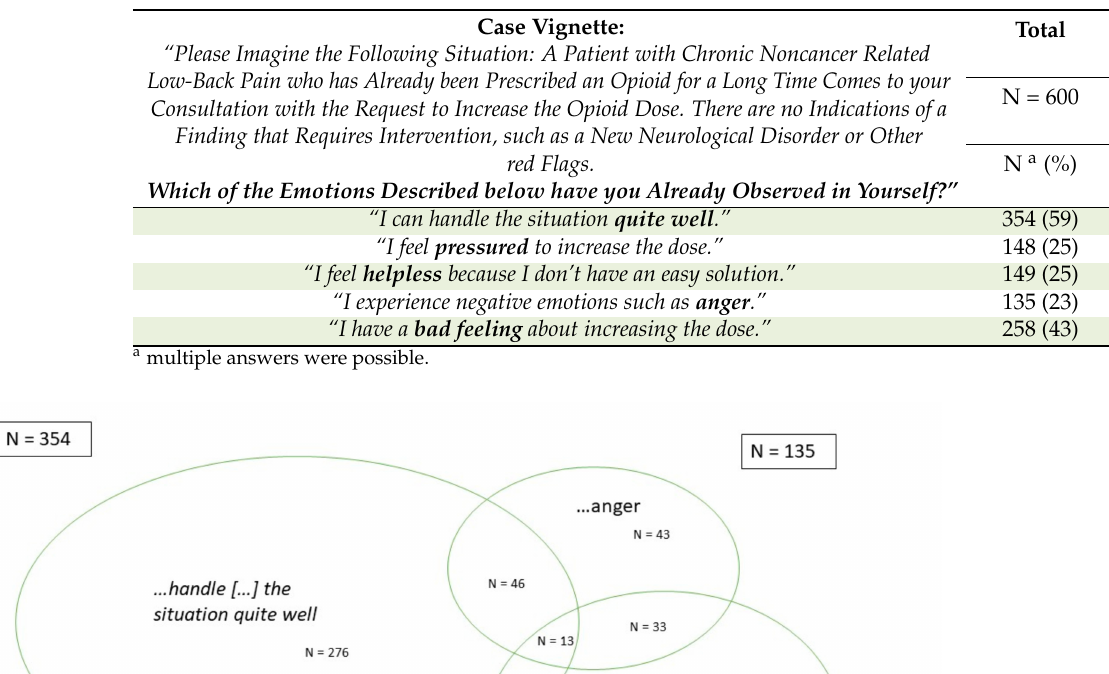
Table 4. Physician self-reported emotional reactions to a patient’s desire to increase opioid dosage in long-term opioid therapy of chronic unspecific low back pain.